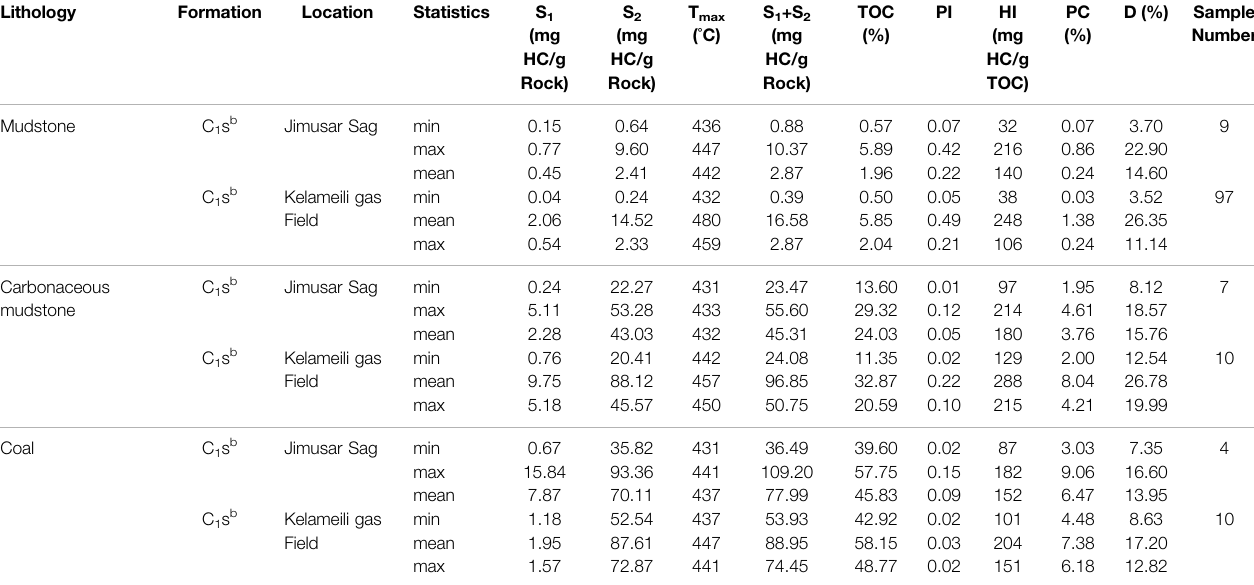
TABLE 2 | The hydrocarbon generating potential of C 1 s b source rocks in the Jimsar Basin. Lithology Formation